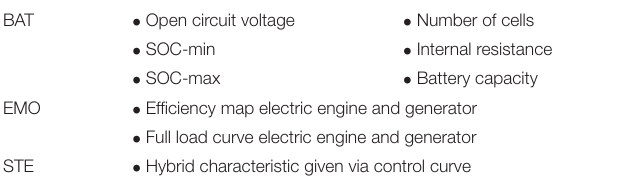
TABLE 9 | Additional Input files for BEV and HEV for PHEM.